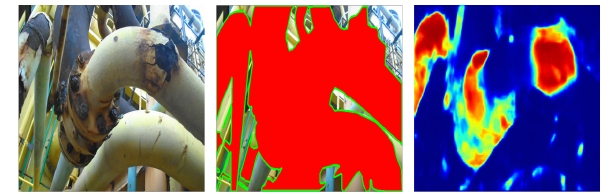
Figure 9. Left: Input image, Center: Label defined by the annotator. Right: Belief map produced by the network